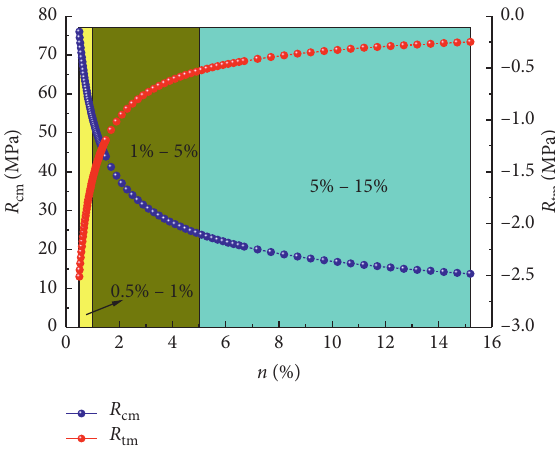
Figure 7: Both R